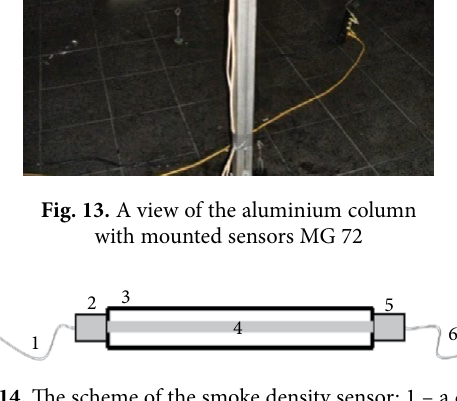
(without piloted ignition) Non-treated time value 65 0.47 1155 0.49